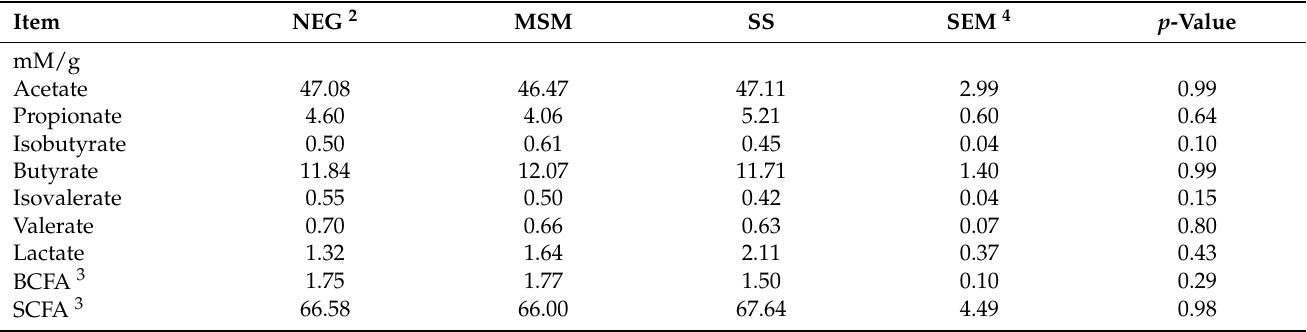
Table 5. Effect of dietary sulfur sources on the concentrations of cecal short-chain fatty acids (mM/g or % of total) in broiler chickens at 21 d of age 1